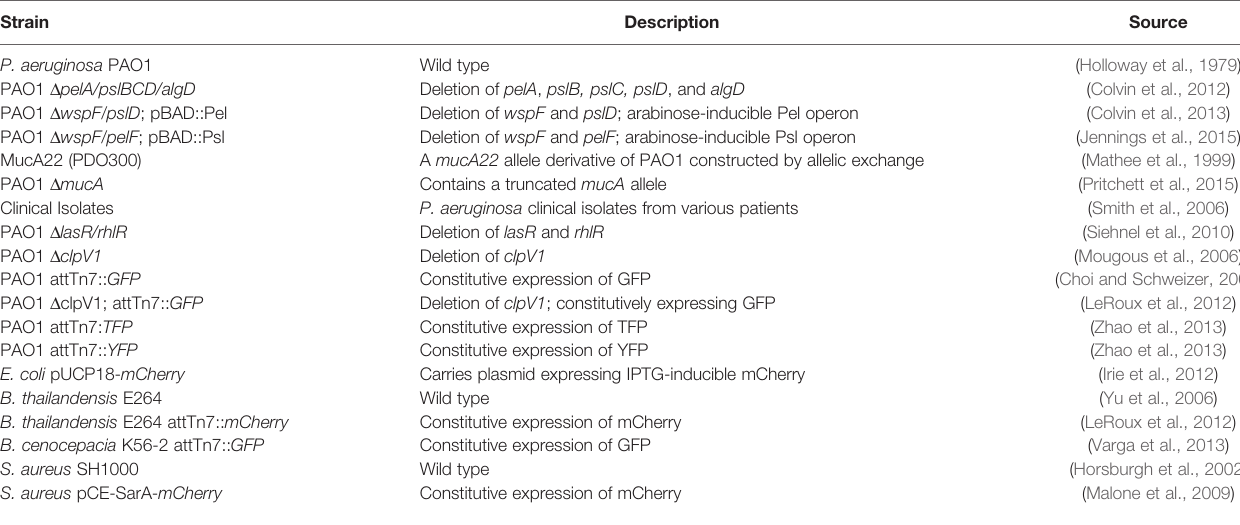
TABLE 1 | Strains used in this